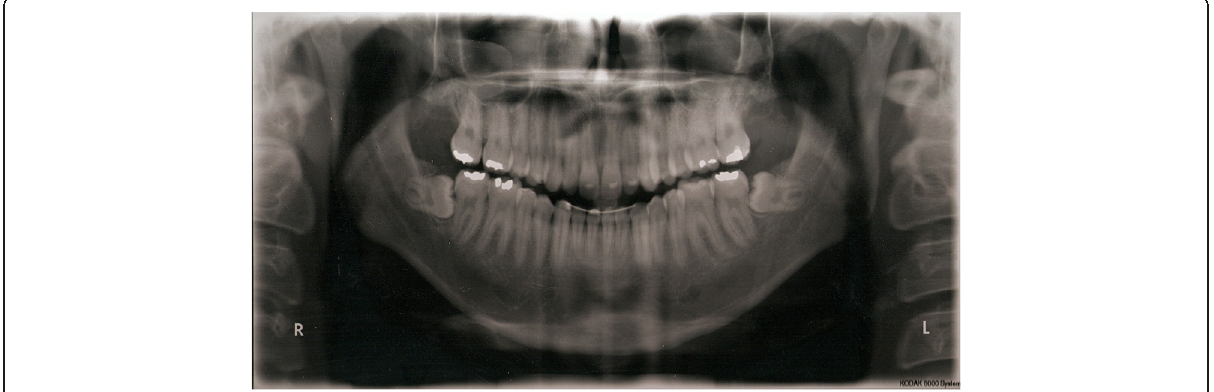
Fig. 2 Panoramic radiograph of the same patient showing the M3 development along 5 years